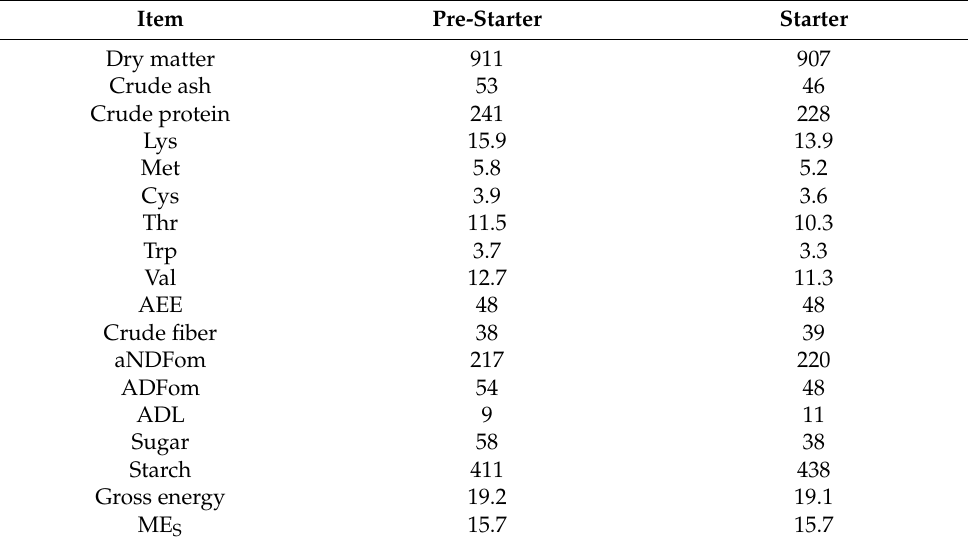
Table 1. Chemical composition of the pigs’ feeds offered during the experiment 1